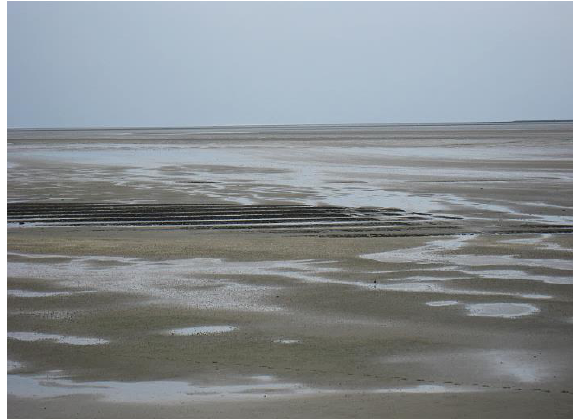
Figure 9. Photograph taken from a dike on Pellworm island and showing manifestations of historical land use as dark parallel lines. Photograph: M.